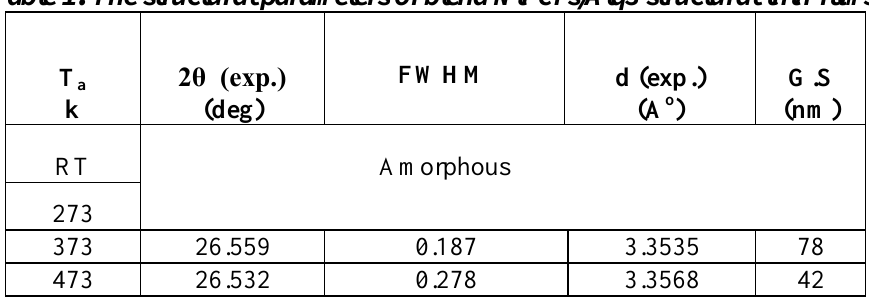
Table 1: The structural parameters of blend NiPcTs/Alq3 structural thin